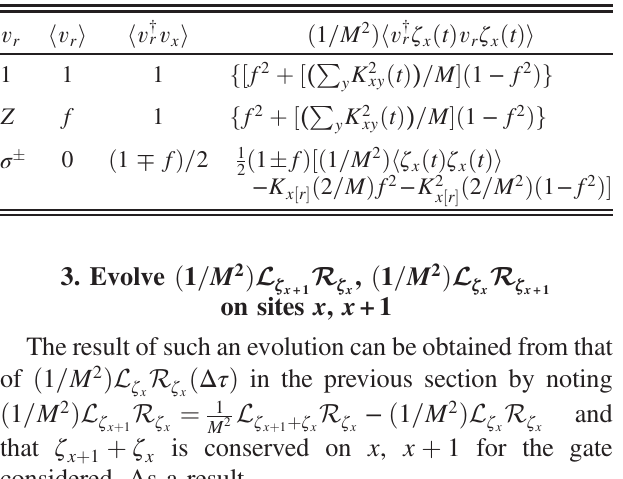
TABLE I. Useful expectation values for manipulating